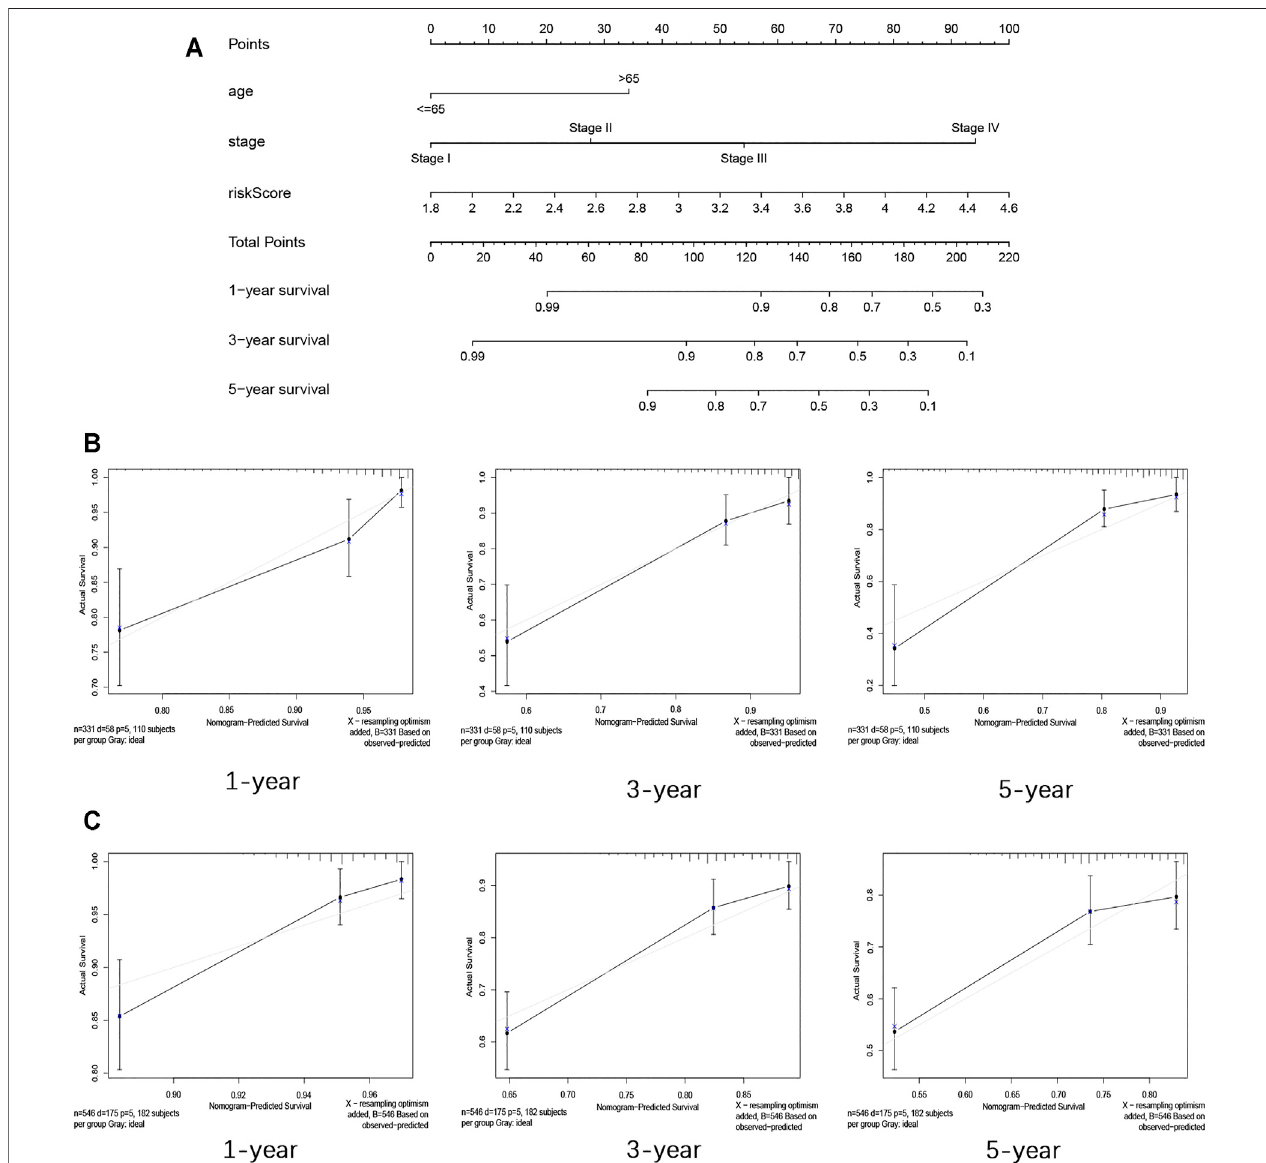
FIGURE 6 | Construction and validation of the nomogram for COAD. (A) Nomogram for predicting the 1-year, 3-year, and 5-year survival rate by age, stage, and risk score. (B) 1-, 3-, and 5-year calibration curves of TCGA dataset. (C) 1-, 3-, and 5-year calibration curves of GEO dataset.